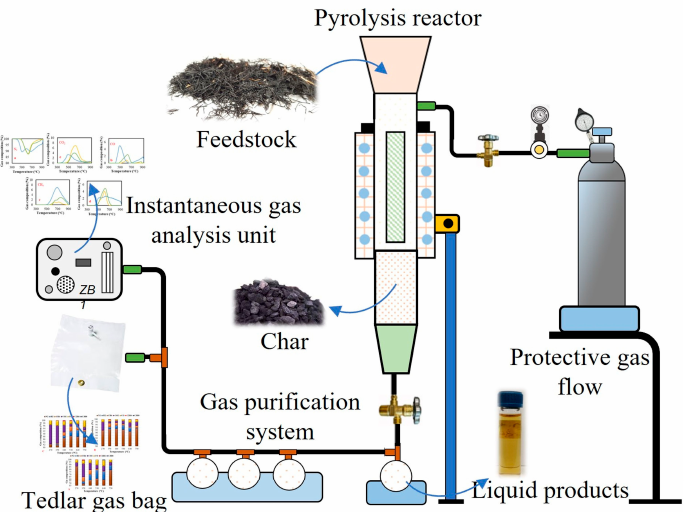
Figure 1. Laboratory-scale pyrolysis plant used for the conversion.